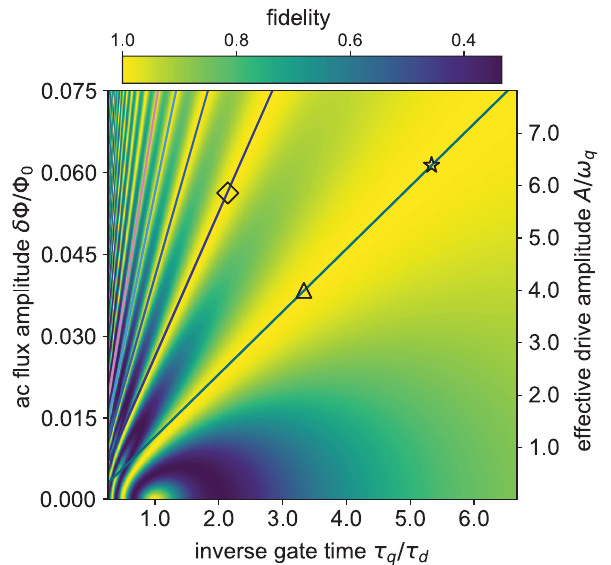
FIG. 6. A variable-time single-qubit identity pulse. We plot the fidelity of an identity operation under a single-period sinu- soidal qubit-flux drive. The lines mark locations in amplitude and frequency space where A = j k ω d / 2 for the first five zeroes j k of J 0 . Multiple other lines of high fidelity corresponding to larger zeros of J 0 are visible in the numerics. These variable- time identity gates are ultrafast, with gate times that can be small compared to the Larmor period. The pointlike region of high fidelity at δφ = 0 corresponds to the passive identity oper- ation. The marked points label example drive parameters used for visualizing Bloch-sphere trajectories in Fig. 7. The numerical simulations are performed using the parameters of qubit b , where / 2 π = 37 MHz. ω q